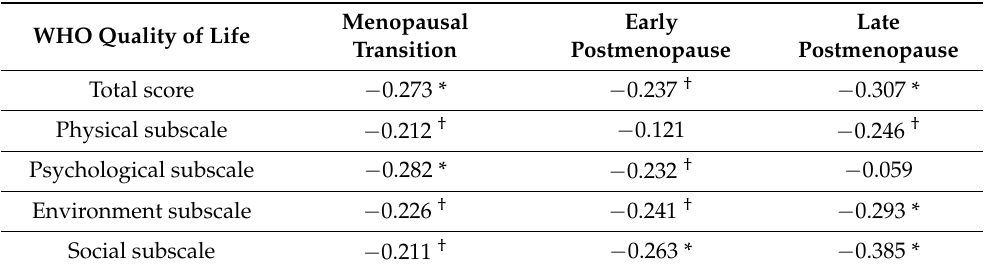
Figure 1. Prevalence of self ‐ perception of aging subscales stratified by reproductive aging stages. Table 3. Association between self-perception of aging and quality of life total score and their subscales, stratified by reproductive aging